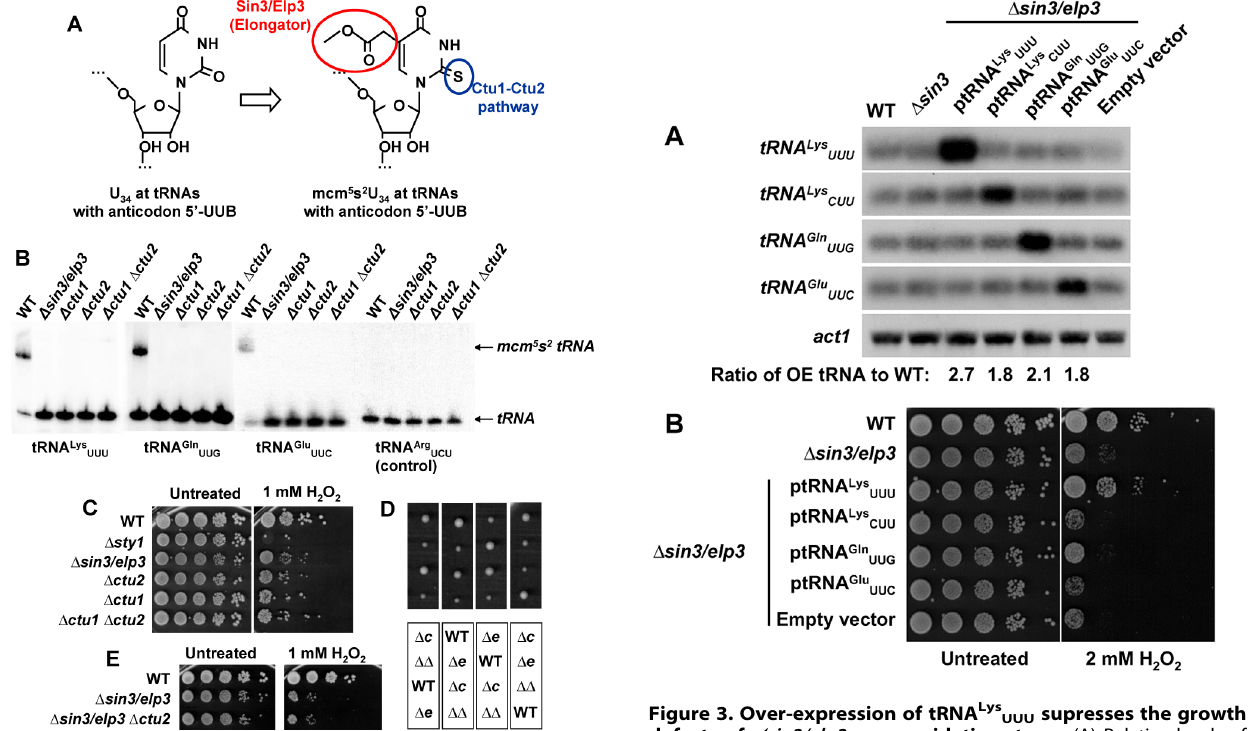
Figure 3. Over-expression of tRNA Lys UUU supresses the growth defects of D sin3/elp3 upon oxidative stress. (A) Relative levels of tRNA over-expression by Northern blot. Total RNA from strains 972 (WT), IV16 ( D sin3/elp3 ), or JF77 ( D sin3/elp3 ) transformed with episomal plasmids p465 (ptRNA Lys UUU ), p466 (ptRNA Lys CUU ), p467 (ptRNA Gln UUG ), p468 (ptRNA Glu UUC ) or the empty vector pREP.42x, was analyzed by Northern blot with probes of dsDNA of the indicated tRNAs labeled at their antisense strand. a ct1 is shown as a loading control. The numbers below last panel indicate the relative levels of the corresponding over- expressed tRNA normalized to basal levels in wild-type strain. (B) Serial dilutions from cultures of strains as in A were spotted onto synthetic rich media plates without (Untreated) or with 2 mM H 2 O 2 .